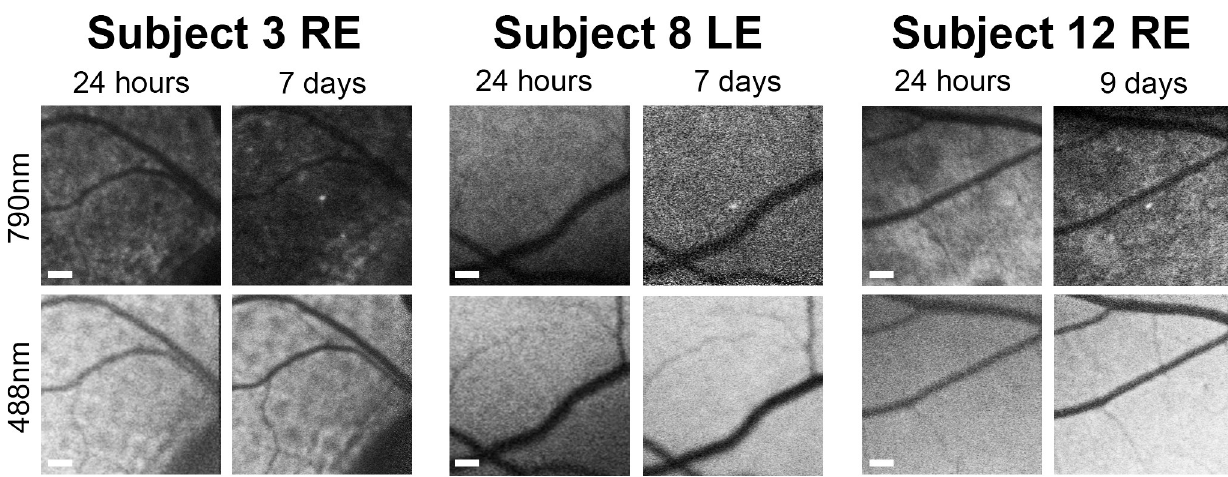
Fig 3. Cell-sized hyperfluorescent near-infrared signals appearing in regions with no prior autofluorescence or RPE signal change during the study. Retinal ICG fluorescence 790 nm excitation channel images are shown alongside matched 488 nm excitation autofluorescence images. Subject 3 had detectable ICG cell staining in peripheral blood. By size and location these could represent weakly ICG labelled cells infiltrating the retina, rather than arising from RPE staining alone. LE = left eye, RE = right eye. Scale bars = 200 μ m.